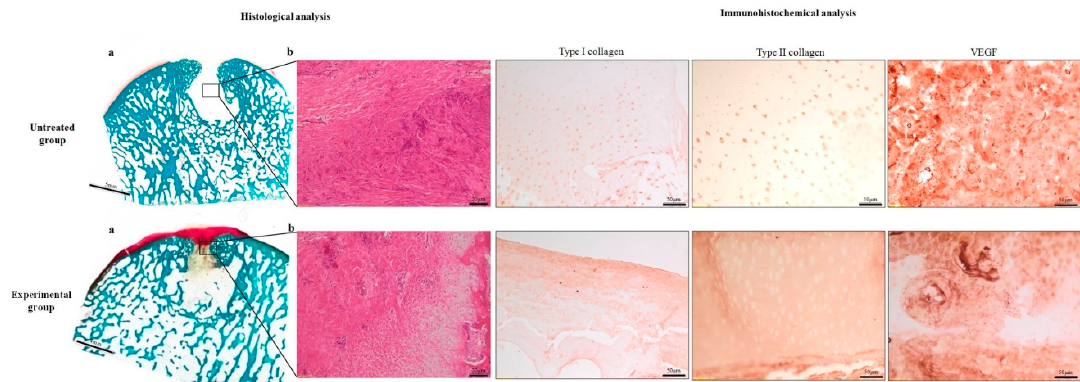
Figure 4. Histological evaluations at six months in the untreated group: ( a ) No evidence of bone and cartilage defect healing, Safranin-O/Fast green stain. Magnification 1×. ( b ) Presence of fibrous tissue in the defect area. H/H staining: Magnification 20×. In the experimental group: ( a ) Safranin-O/Fast green stain. Magnification 1×. ( b ) Cartilage defect filled with fibrous tissue resembling fibrocartilage. H/H staining: Magnification 20×. The immunohistochemical panel showed the staining for type I, type II collagen, and VEGF. Magnification 10×.